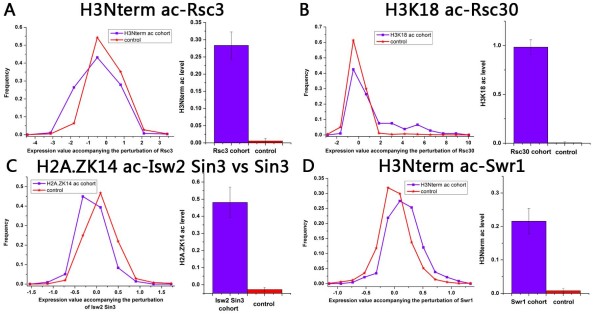
Selected significant modification-remodeling pairs. (A-D) Distributions of expression levels (log2 transformed) accompanying the perturbation of the remodeler are presented for the modification cohort and the control group (rest of the genes). Modification levels at promoters are also shown for the remodeling cohort and the control group. Ac represents acetylation, while me indicates methylation (e.g. me3 indicates trimethylation). Error bars were calculated by bootstrapping.